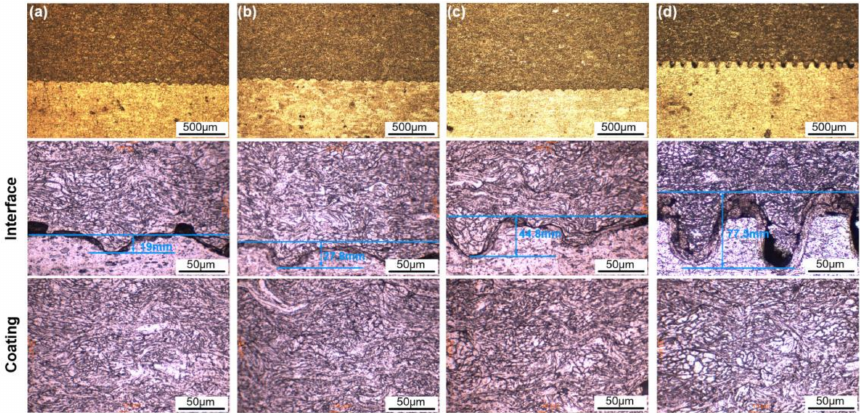
Figure 3. Microstructures of the samples with ns laser assisting. ( a ) Sample #1; ( b ) sample #2; ( c ) sample #3; ( d ) sample